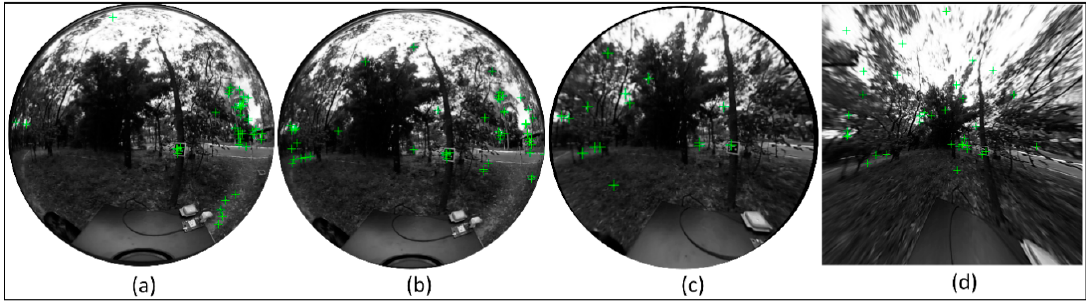
Figure 9. Experiment I: Example of match distribution for dataset II with ( a ) standard SIFT, ( b ) SIFT RFS , ( c ) pSIFT, and ( d ) SIFT RTF .